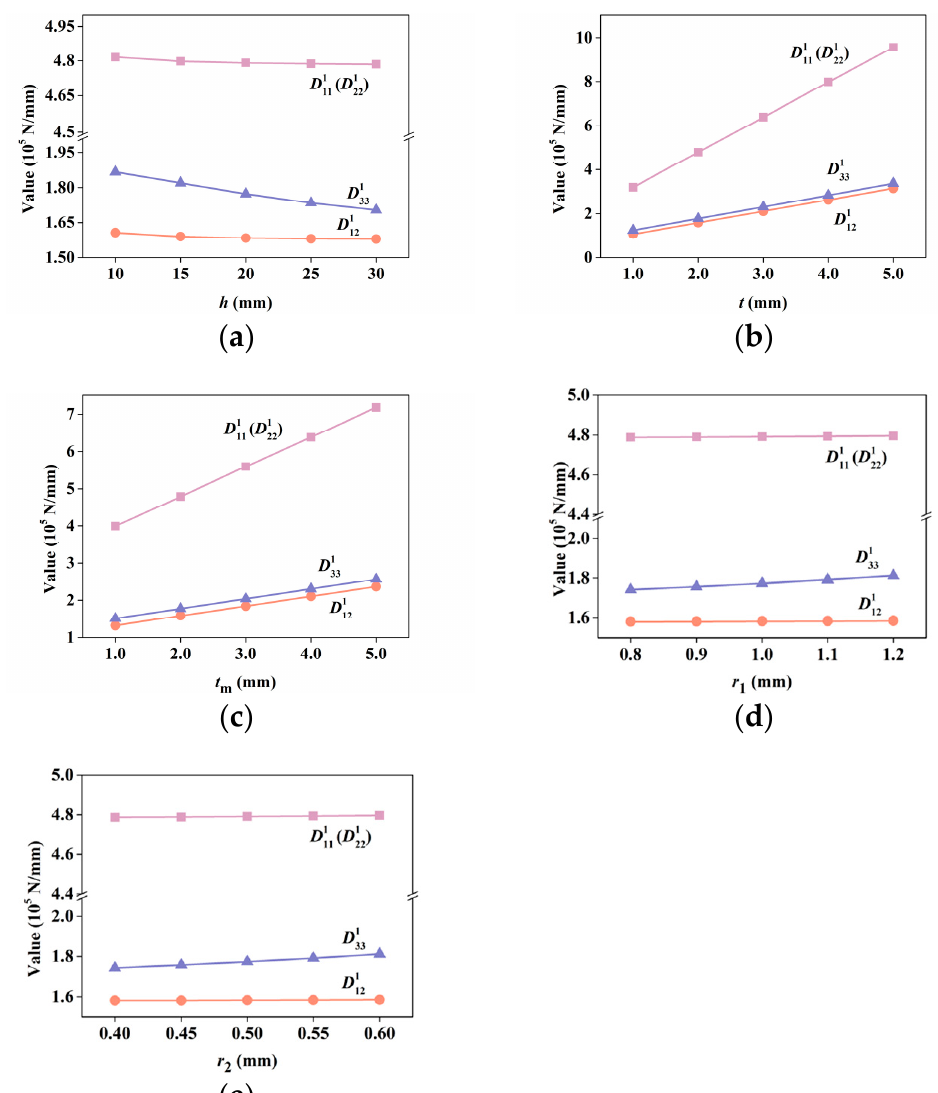
Figure 7. Tensile stiffness coefficients in D 1 by S-NIAH versus various unit cell parameters ( h , t , t m , r 1 , and r 2 ): ( a ) lattice height h , ( b ) upper and lower bound plate thickness t , ( c ) inner plate thickness t m , ( d ) radii of robs in spare layer r 1 , and ( e ) radii of robs in dense layer r 2 . The variations in tensile stiffness D 4 versus various unit cell parameters are shown in Figure 8. The considered parameters are the same as mentioned earlier. It can be seen that h and t have large effects on the values of the coefficients in D 4 , whereas other parameters show little effect. D 4 represents the bending stiffness, and changing h and t directly changes the bearing area or the moment of inertia; thus, the variation in the lattice height thickness of the upper and lower bound plate directly affects the values of the coefficients in D 4 . The difference is that the influence of t is linear, whereas that of h is